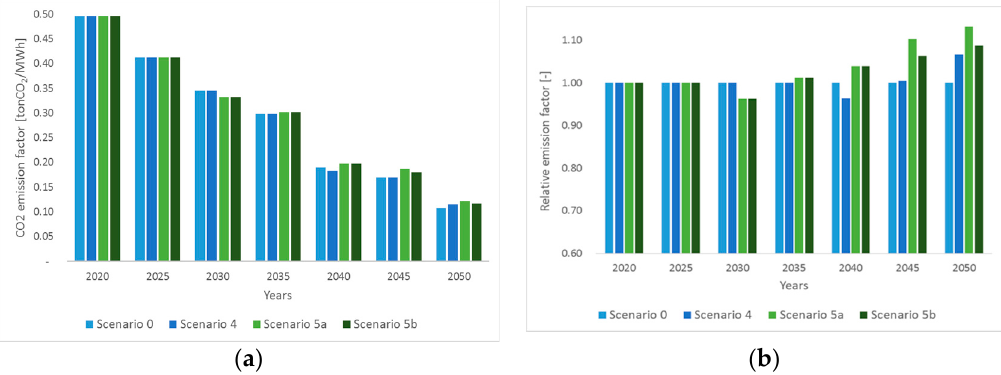
Figure 8. Evolution of the absolute emission factor ( a ) and the relative emission factor with respect to Scenario 0 ( b ) for Scenarios 4 and 5.